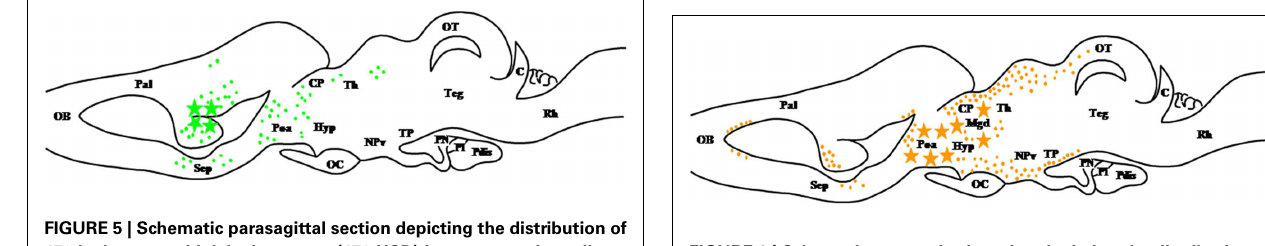
FIGURE 6 | Schematic parasagittal section depicting the distribution of hydroxysteroid sulfotransferase (HST)-immunoreactive cell bodies (stars) and fibers (dots) in the central nervous system of Rana esculenta (Beaujean et al., 1999). For other designations, see Figure 2